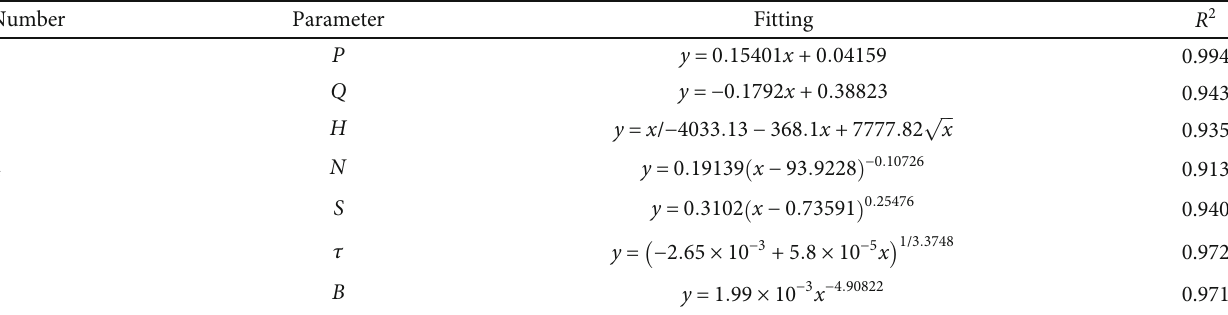
Table 7: Parameter inversion data fi